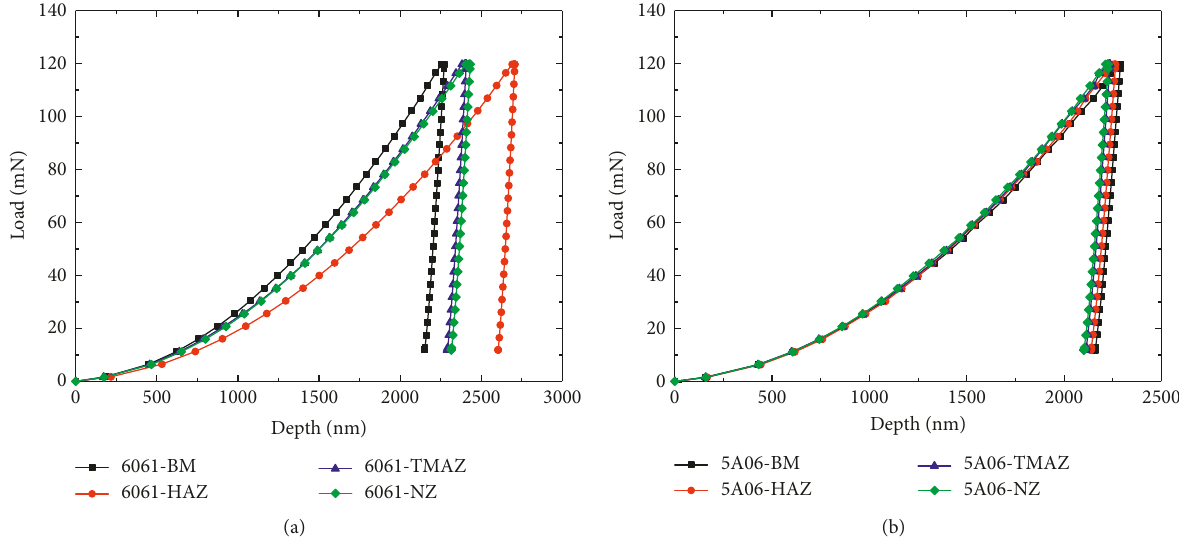
Figure 6: Typical nanoindentation load-depth curves for different areas of the FSW joint at (a) the AA 6061 side and (b) the 5A06